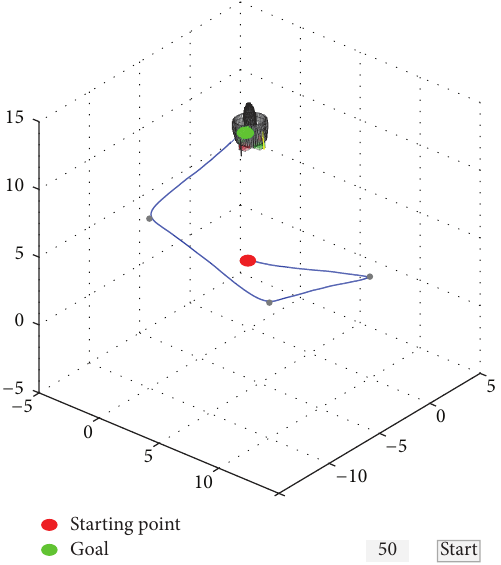
Figure 14: Visualization environment of the simulation.